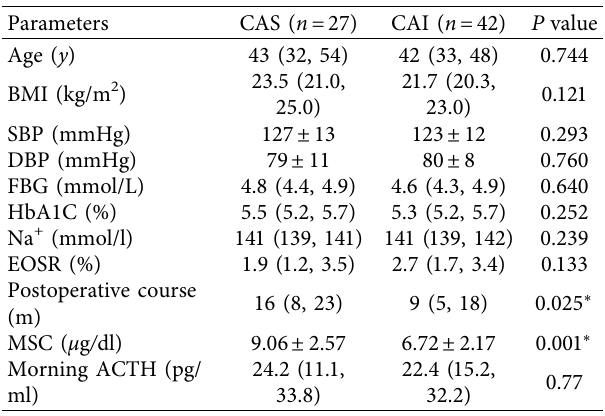
Table 2: Characteristics of the patients of CAS and CAI.